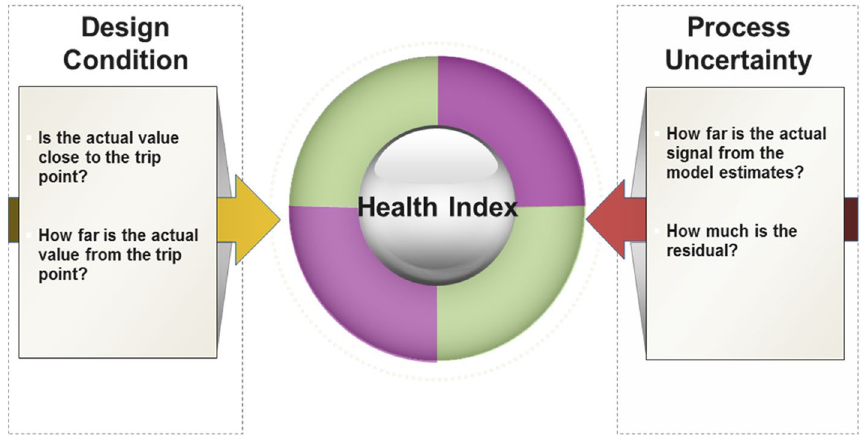
Figure 5. Health Index accounts for deviations of actual measurement from design and nominal conditions.